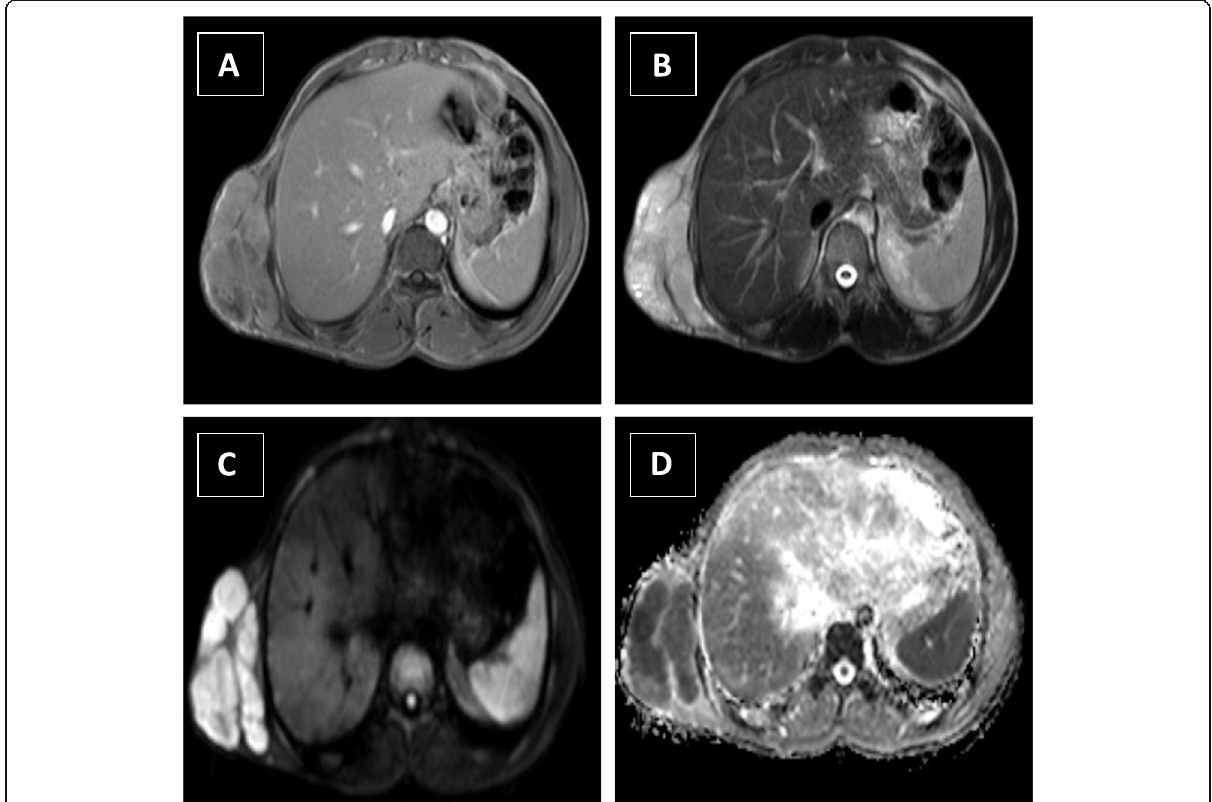
Fig. 2 A 20-year-old male patient presented with right axillary progressive swelling. MRI chest wall shows an ill-defined soft tissue mass lesion at the lower right lateral chest wall with no chest wall infiltration, eliciting isointense signal intensity in T1WI ( a ), high signal intensity in T2 WI ( b ), and restricted diffusion in the form of high signal in diffusion ( c ) and low signal in ADC map ( d ). The ADC value was 0.4 ± 0.03 × 10 − 3 mm 2 /s, and the mass was pathologically proven to be a primitive neuro-ectodermal